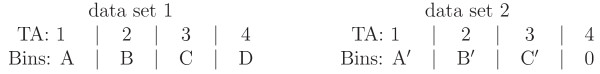
Example of a one-to-one MicroMerge v2 alignment for the data sets in Figure 2. In this case C' in data set 2 corresponds only with bin C in data set 1. TA is an abbreviation for "theoretical alleles".